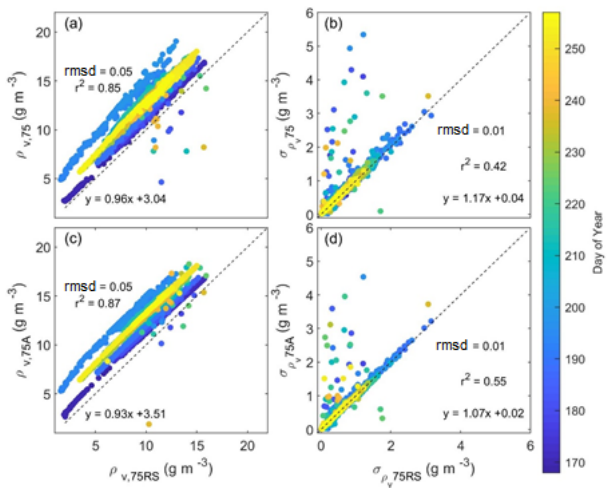
Figure 4. Intercomparison of absolute humidity ρ v means and stan- dard deviations for (a, b) the LI-7500 and LI-7500RS and (c, d) the LI-7500A and LI-7500RS.